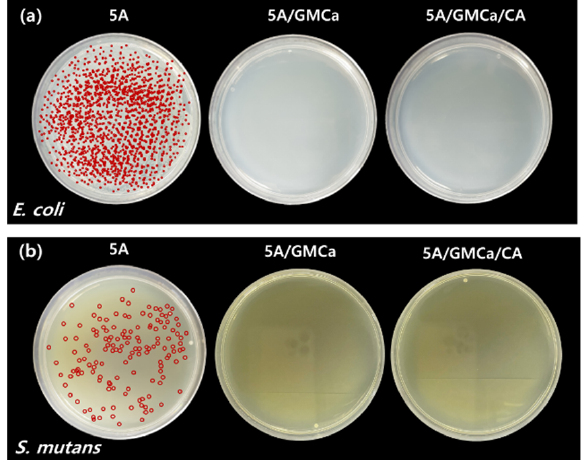
Figure 4. Assays were conducted against gram-negative E. coli ( a ) and gram-positive S. mutans ( b ). An antibacterial effect was observed in the agar plates inoculated with 100 μ L of supernatant PBS solution immersed with chitosan-alginate-gentamicin (2A/x%3CGMCa, x = 0.1, 0.5, 1.0) beads containing different content of chitosan. There was no antibacterial activity by the extract from chitosan-alginate beads (2A/x%3C, x = 0.1, 0.5, 1.0).